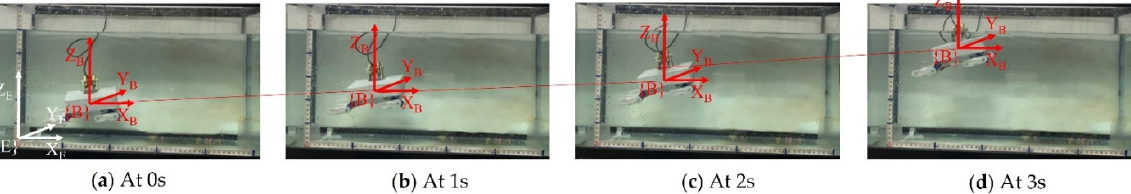
Figure 22. Experiments on floating motion in a swimming motion.